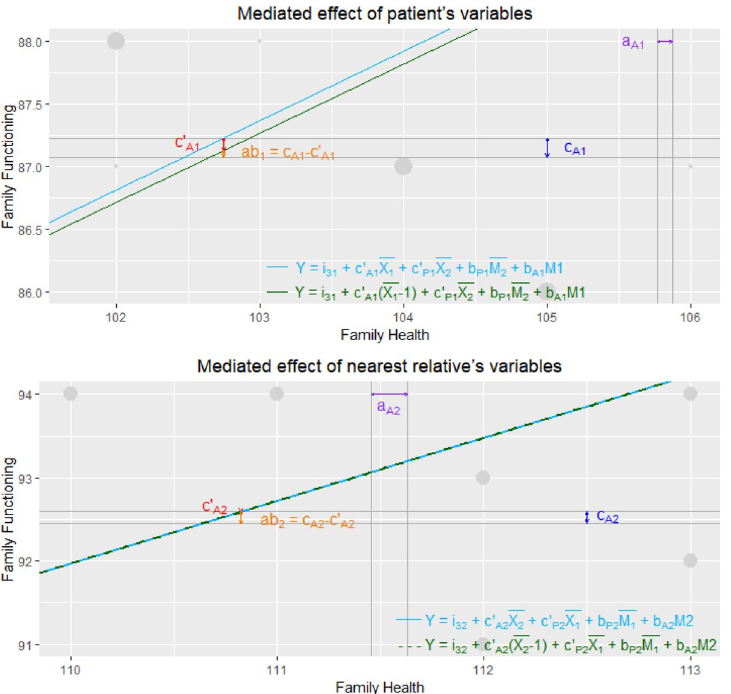
Fig 2. A graphical representation of the mediated effect for patients and nearest relatives. For clarity reasons, only a small section of the overall graph is presented. Dots represent participants scores, with larger dots representing more observations. The distance between the vertical lines (i.e., a A1 and a A2 ) represents the predicted unit change in family health for a one unit change in social support for patients and nearest relatives, respectively. The distance between the horizontal lines (i.e., c A1 and c A2 ) depicts the predicted unit change in family functioning for a one unit change in social support. The distance between the two regression lines (i.e., c’ A1 and c’ A2 ) outlines the predicted unit change in family functioning for a one unit change in social support when holding the other mediating and predictor variables constant. The slope of the regression lines is the predicted unit change in family functioning for a one unit change in family health, adjusted for social support of both roles and family health of the other role. Finally, the indirect effect (i.e., ab 1 and ab 2 ) is the difference between the total effect (i.e., c A1 and c A2 , respectively) and the direct effect (i.e., c’ A1 and c’ A2 , respectively). Note. a (aA1/aA2), effect of perceived social support on family health; c (cA1/cA2), total effect of perceived social support on family functioning; ab, indirect effect of perceived social support on family functioning; c’, direct effect of perceived social support on family functioning. Blue and red slopes indicate effect of family health on family functioning.